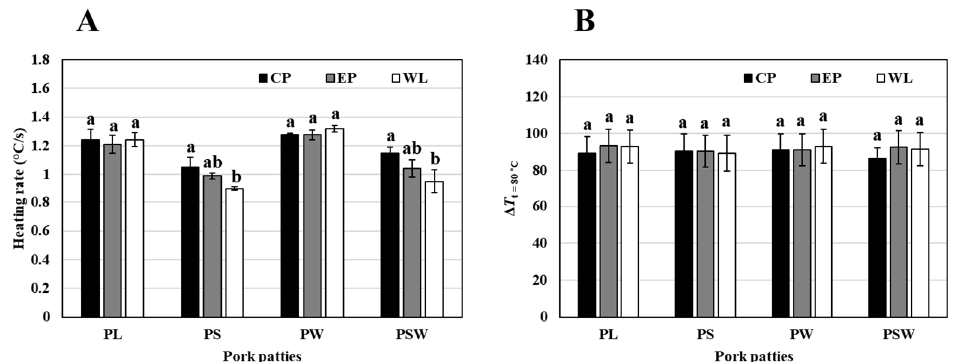
Figure 6. ( A ) The average heating rate and ( B ) the average temperature when the slowest heating part of the pork patties (prepared with different compositions heated in various container designs) reached 80 ◦ C ( ∆ T t=80 ◦ C ). CP: container with center-perforated lid; EP: container with edge-perforated lid; WL: container without a lid; PL: pork only; PS: pork + 2% salt; PW: pork + 10% water; PSW: pork + 2% salt + 10% water. Values in the same sample with different lowercase letters denote significant differences ( p < 0.05).